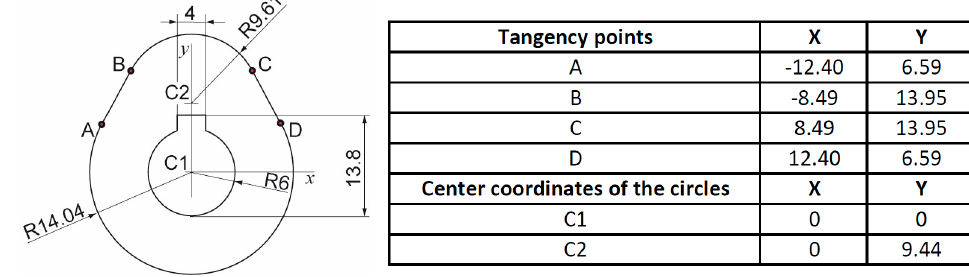
Figure 8. Example of the determination of the tangency points in the milled cam profile (units are mm).